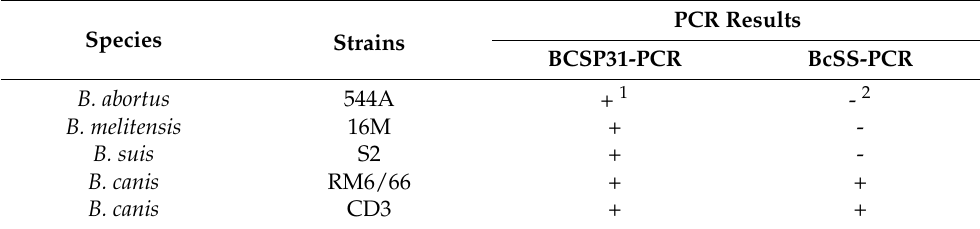
Table 4. Allelic profiles of three B. canis strains isolated from pet dogs in Sichuan,